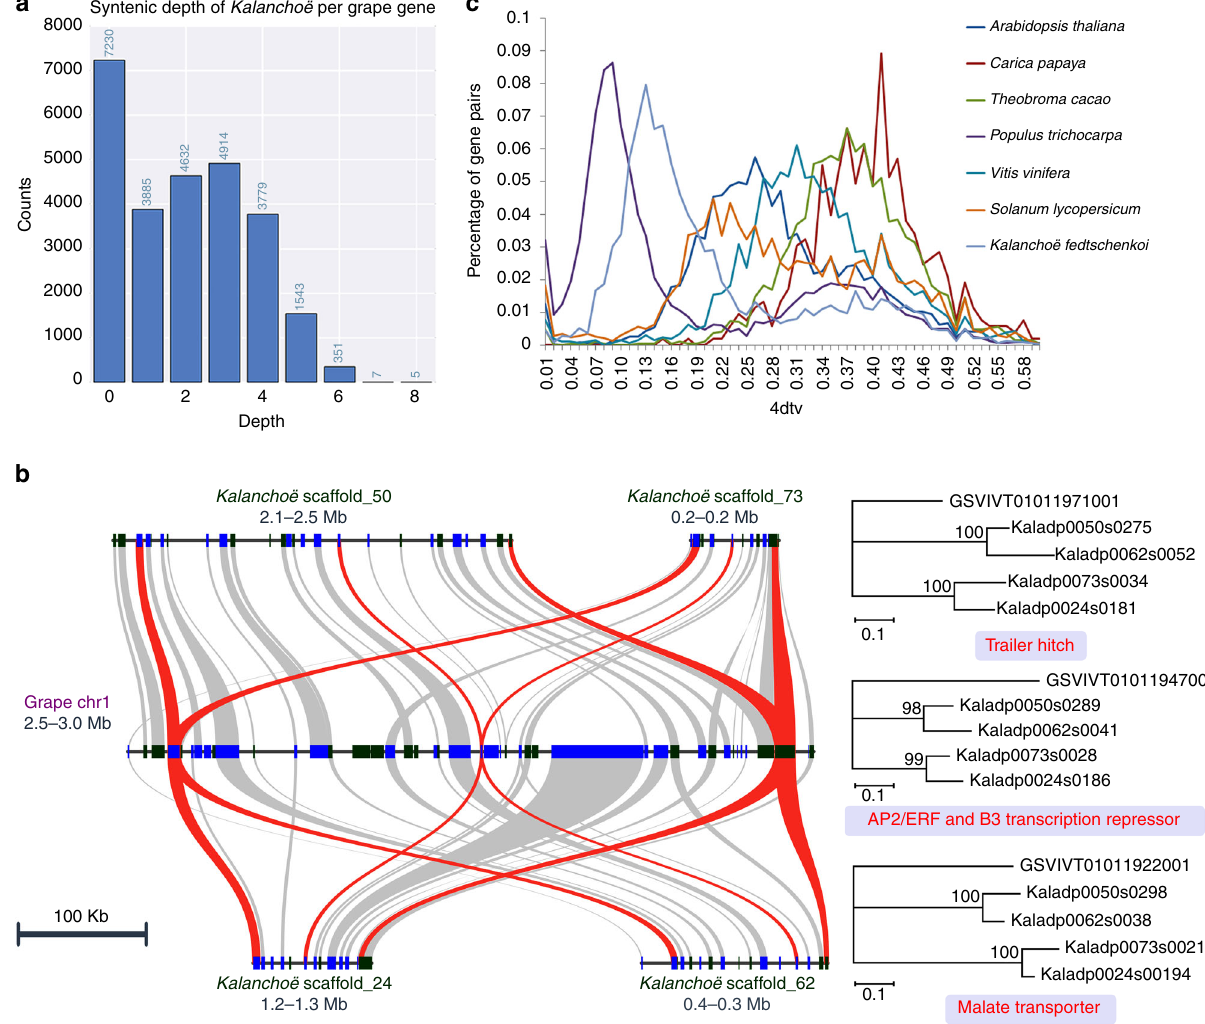
Fig. 2 Genome duplication in Kalanchoë fedtschenkoi . a Syntenic depth of the K. fedtschenkoi genome for each grape gene. Syntenic depth refers to the number of times a genomic region is covered by synteny blocks against another genome. b Typical micro-colinearity patterns between genomic regions from grape and K. fedtschenkoi . Rectangles show predicted gene models with colors showing relative orientations (blue: same strand, black: opposite strand). Matching gene pairs are displayed as connecting shades. Three orthologous gene groups that were maximally retained as four copies in K. fedtschenkoi were highlighted with phylogenetic trees on the right suggesting two rounds of genome duplications in the Kalanchoë lineage. c Four-fold transversion substitution rate (4dtv) in K. fedtschenkoi and six other eudicot plant